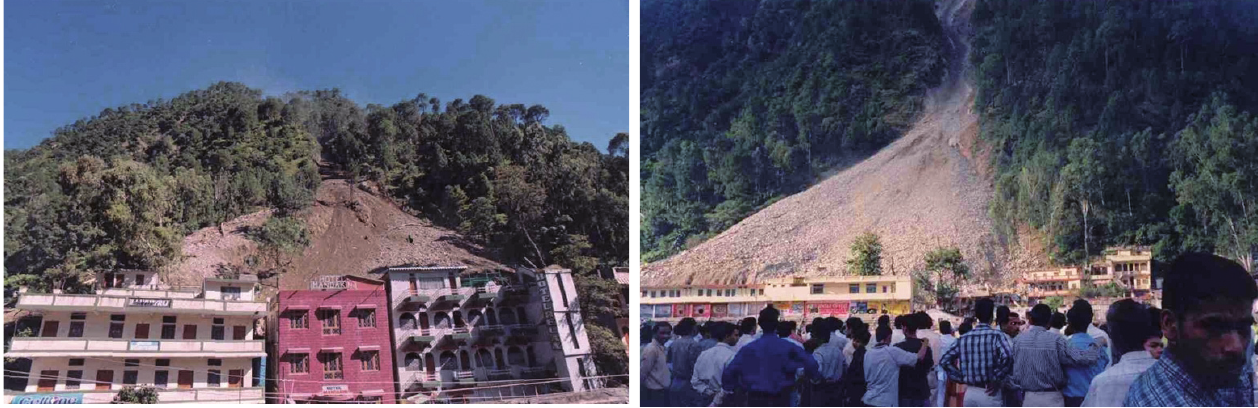
Figure 7 (left). The three four-storey hotels in the Varunawat hills in Uttarkashi Town on September 25, 2003, just the day before these buildings got buried under the landslide debris. Figure 8 (right). View of the landslide after the burial of the hotels, with people watching in